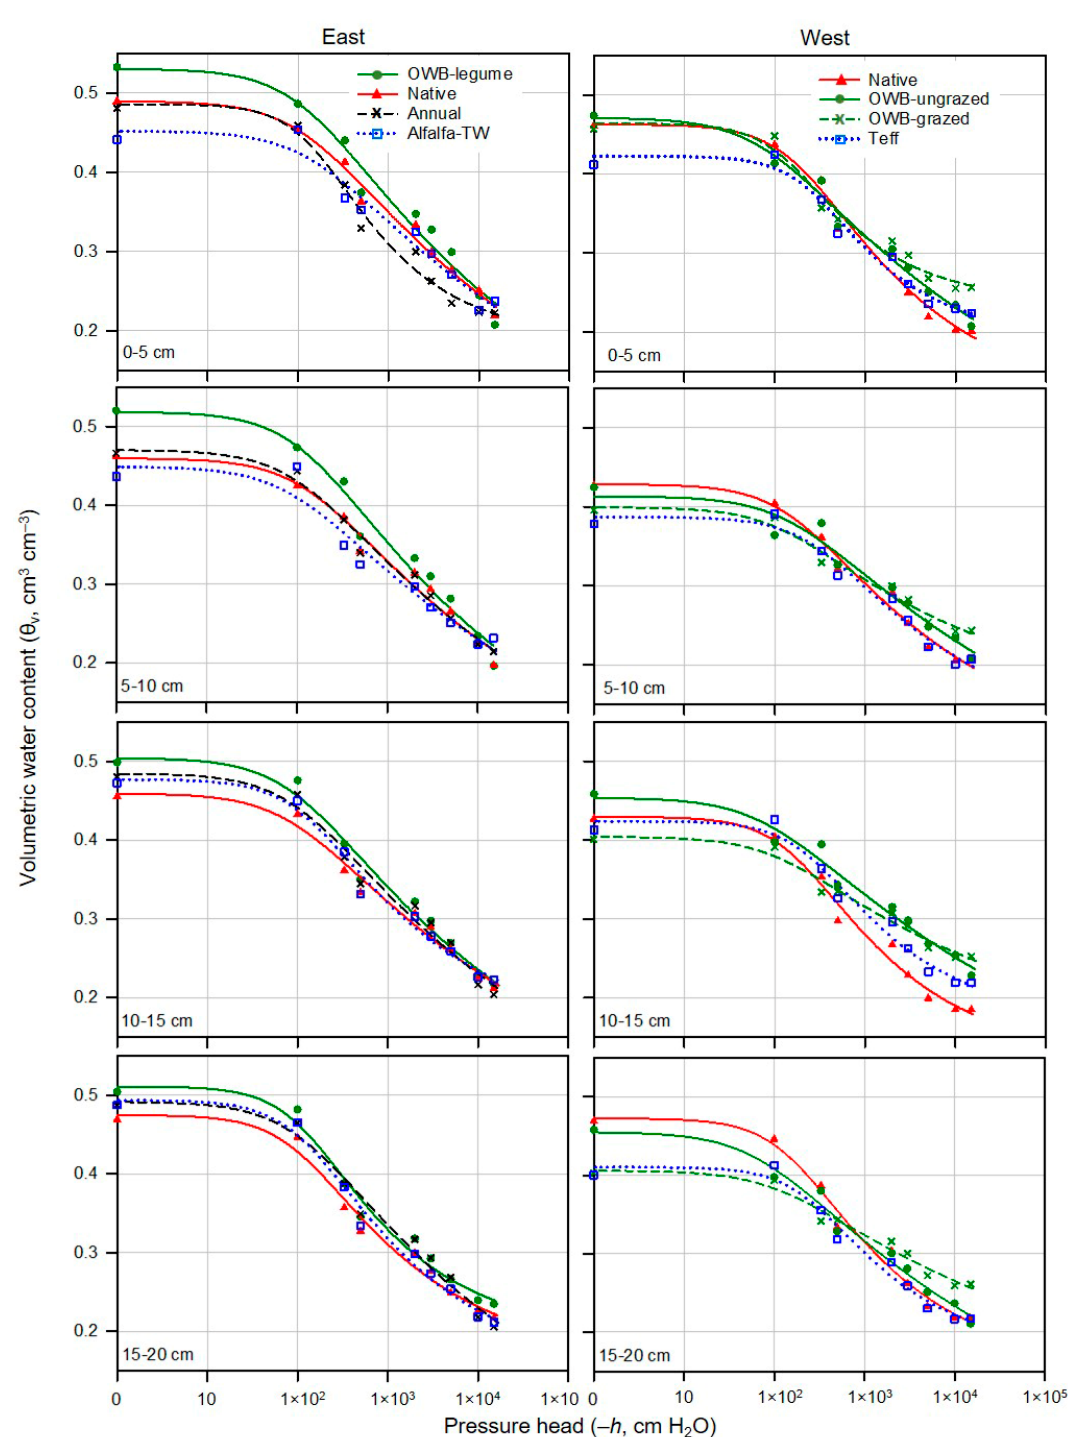
Figure 4. Measured (symbols) and fitted (lines) van Genuchten soil water retention curves (SWRCs) at 0–5, 5–10, 10–15, and 15–20 cm soil depths for all treatments in the east and west pasture area during a 2-year study period (2016–2017). Measured data represent average value across sampling points, replicates, and years, whereas fitted line was obtained using all sample replicates. OWB, Old-World bluestem; TW, tall wheatgrass.